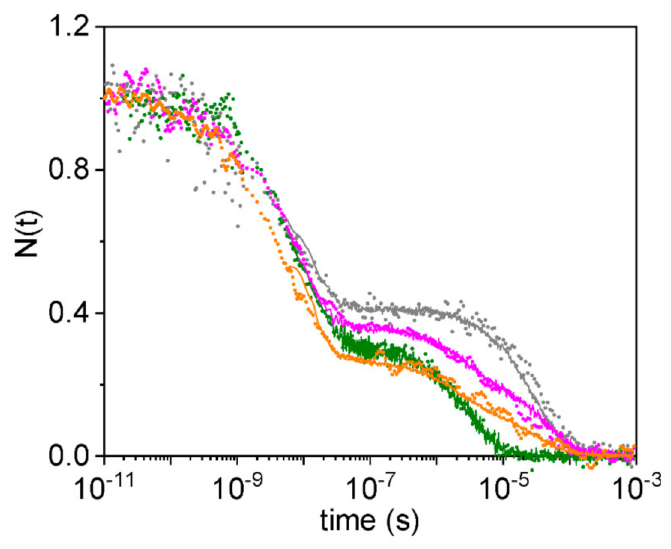
Figure 2. CO rebinding kinetics for WT1 (gray dots) solution equilibrated with 1 atm CO and at room temperature collected with the hybrid femtosecond–nanosecond pump–probe setup. The corre- sponding kinetics measured after nanosecond LFP is reported as a gray solid line. For comparison, the rebinding kinetics to single and double His d mutants are reported (orange, 238; magenta, 74; olive, 74/238; see Section 2.4 for